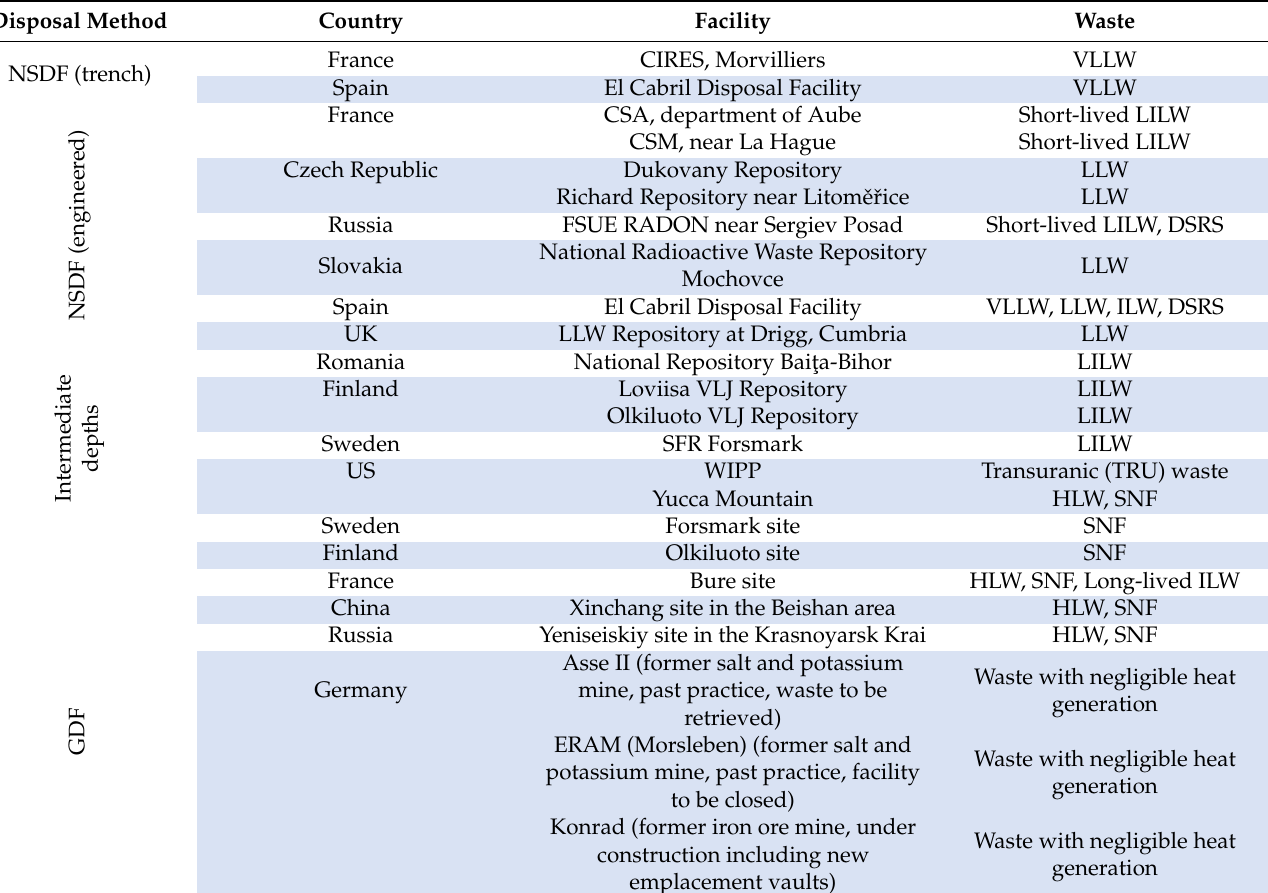
Table 9. Nuclear waste disposal methods and operating or planned disposal